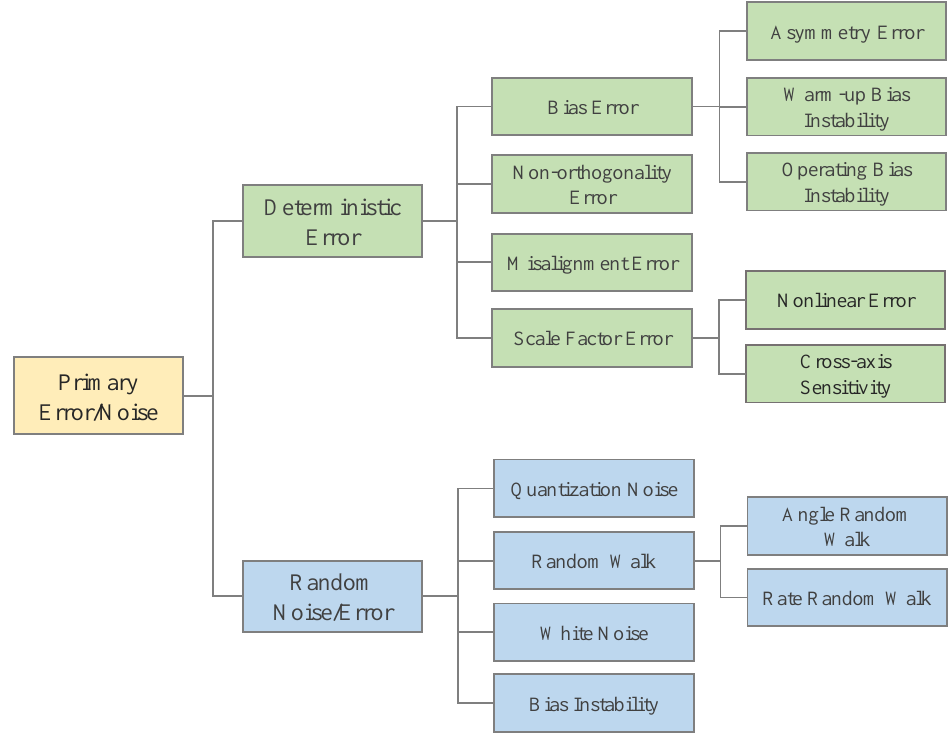
Figure 2. Some momentous errors and noise classification of inertial